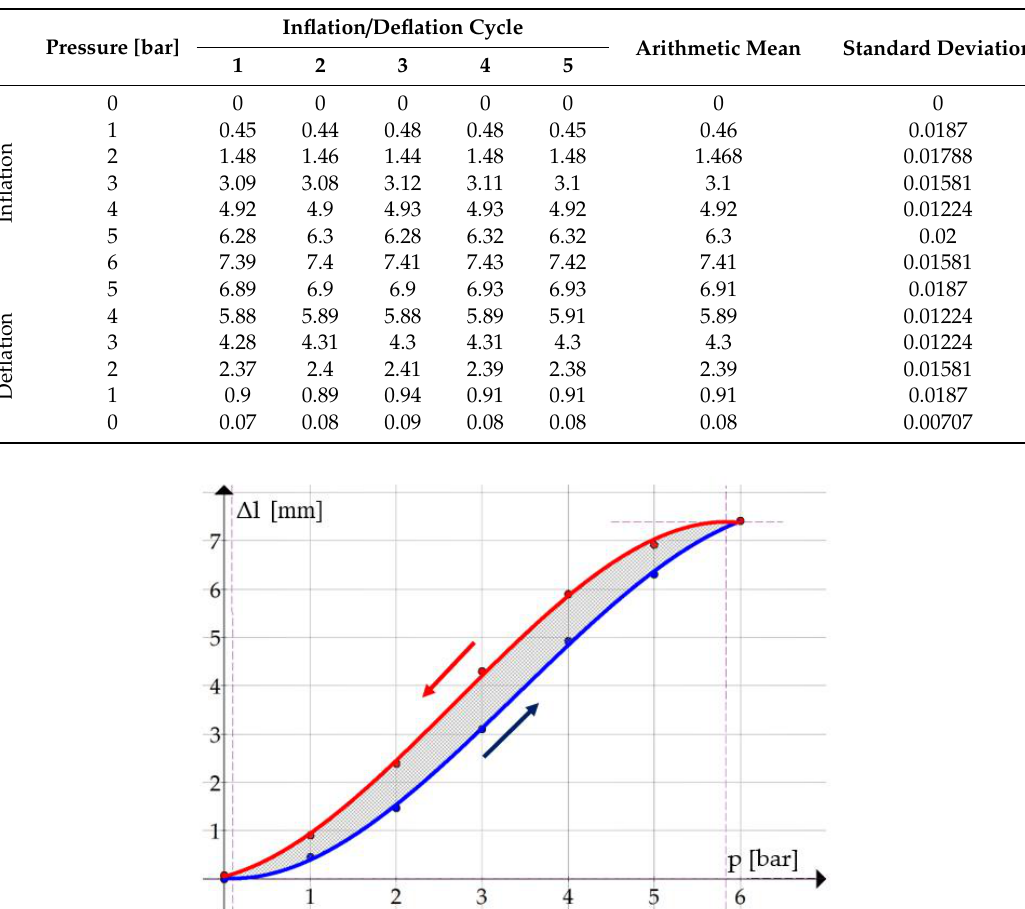
Table 3. Axial contraction of the pneumatic muscle for zero external load.